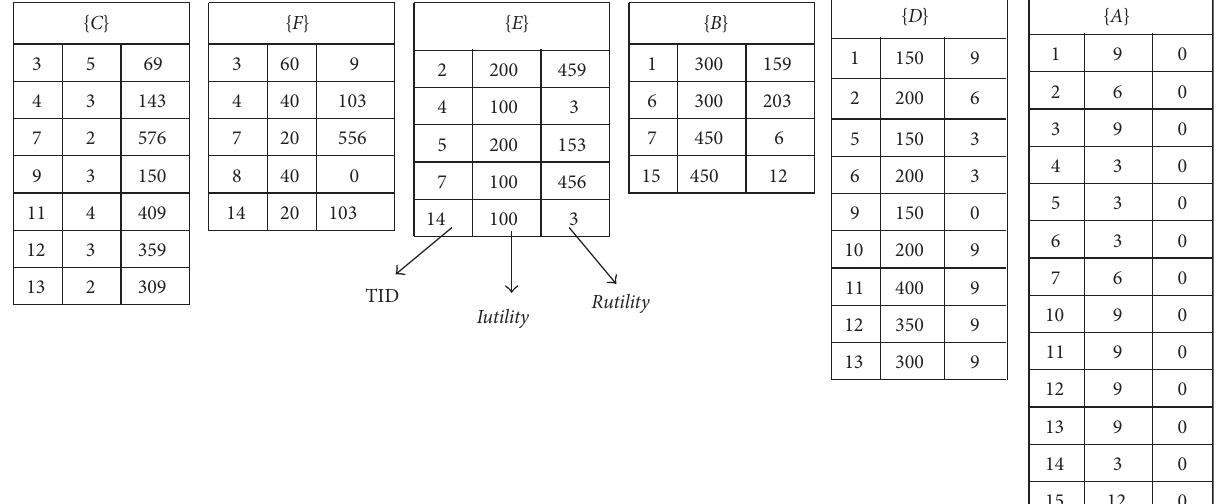
Figure 4: The final merged utility-list structures for the updated